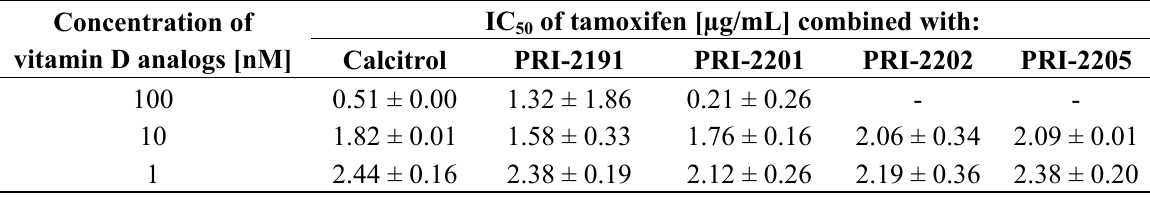
Table 6. The antiproliferative activity of tamoxifen used after preincubation with calcitriol or its analogs against MCF-7 cells (counted as IC